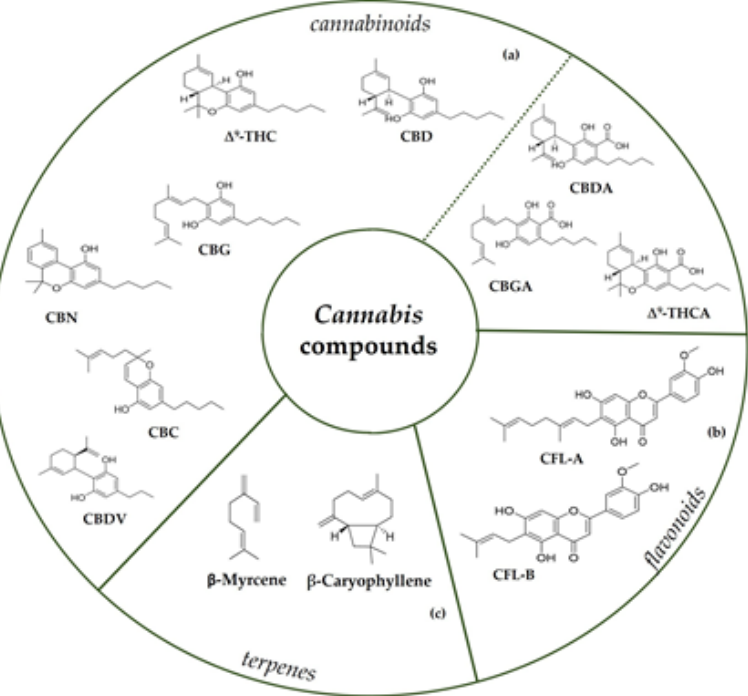
Figure 3. Chemical structures of main cannabinoids (a) both in neutral and acid form (separated by dashed line); flavonoids (b) , as CFL ‐ A and CFL ‐ B; terpenes (c) in Cannabis sativa L.